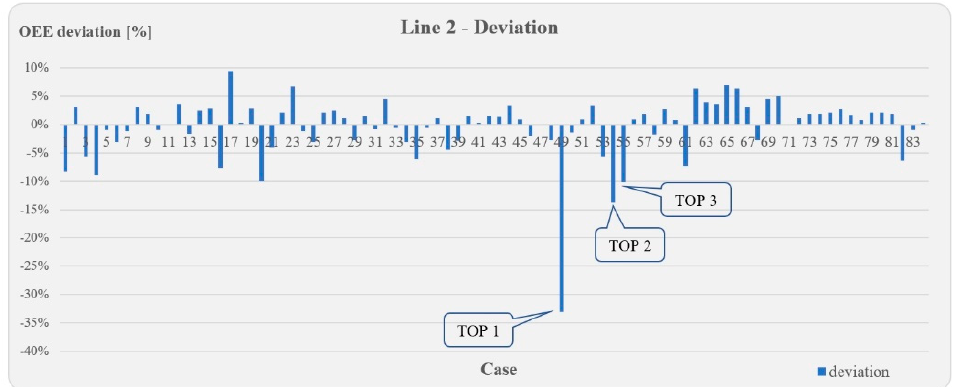
Figure 4. Deviation from the estimation for assembly line 1.